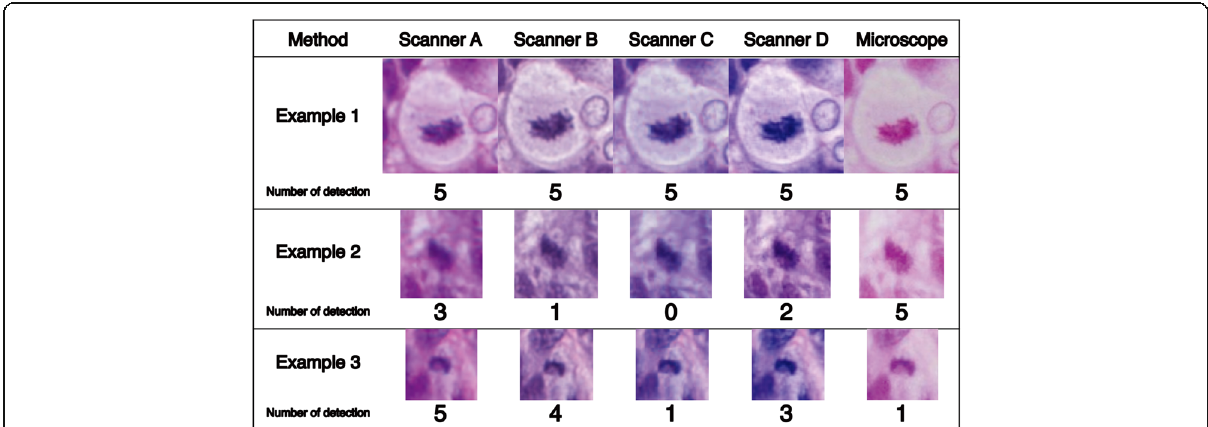
Fig. 1 Examples of ground truth in mitotic cell imaging. Three examples of ground truth for mitotic cell imaging are shown. Example 1: images of mitotic cells obtained by all observers using all observation methods included microscopy; example 2: no participant detected mitotic cells, using scanner C; example 3: only one observer detected mitotic cells upon microscopic examination